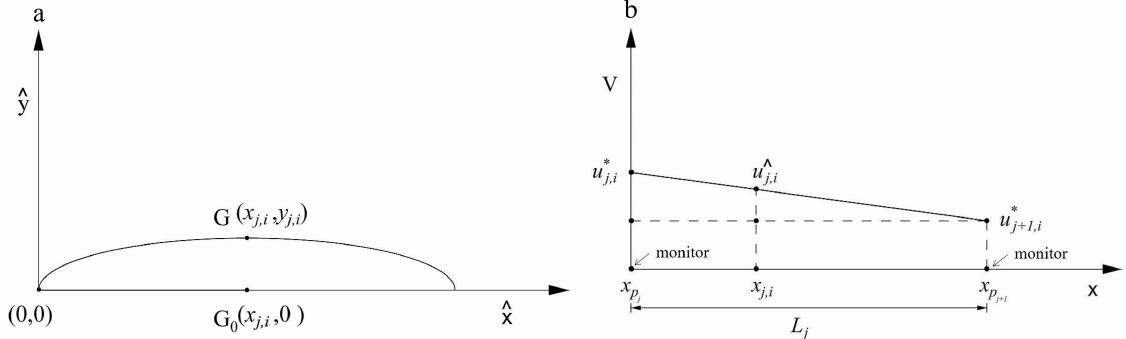
Figure 2. Schematic diagram of dividing the ski field racetrack.